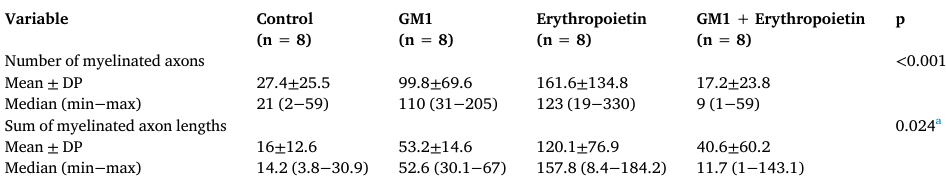
Table 5 Description of immunohistochemical parameters per group and results of comparative tests.